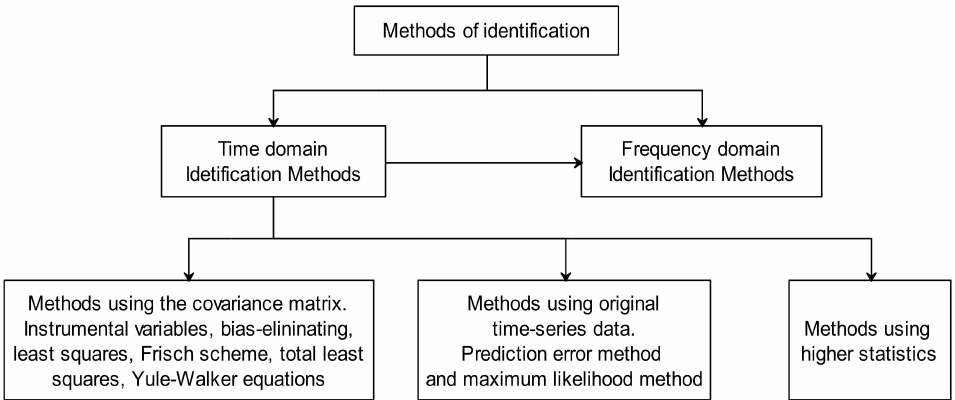
Figure 2. Classification of identification methods of the autoregressive model in presence of an additive